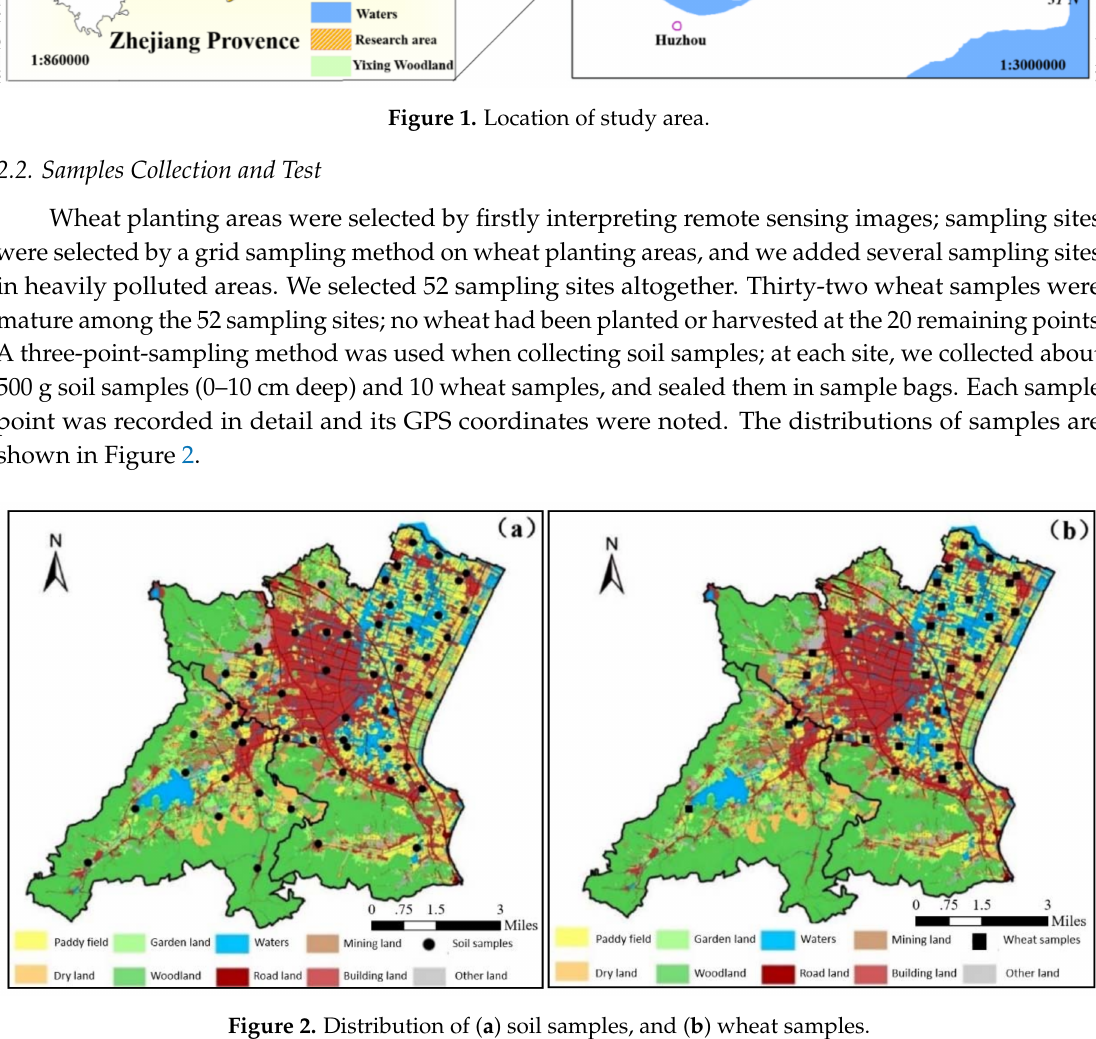
Figure 2. Distribution of ( a ) soil samples, and ( b ) wheat